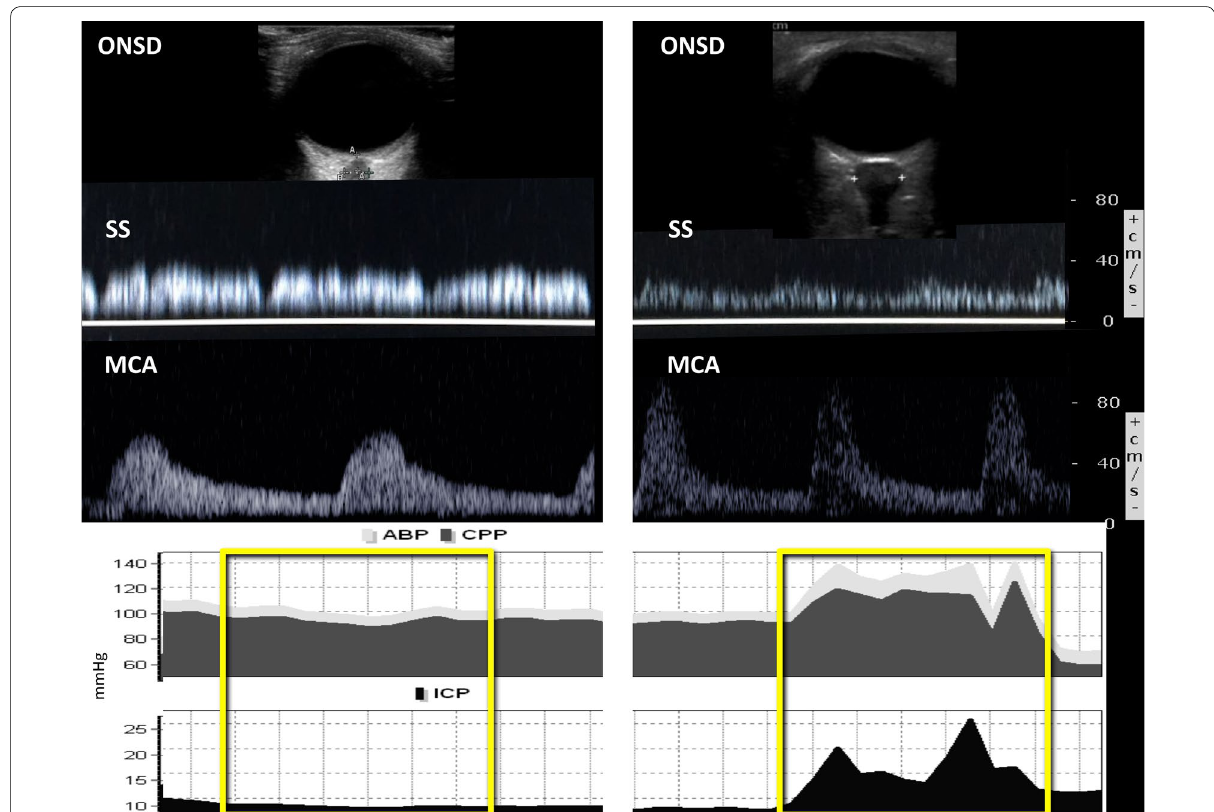
Fig. 2 Invasive and non-invasive intracranial pressure monitoring, respectively, through ICP Bolt and through brain ultrasound (BUS, optic nerve sheath diameter and cerebrovascular Doppler sampling) in a patient with traumatic brain injury and ARDS. A 26-year-old lady was admitted to the intensive care unit after a road traffic accident. She presented with severe traumatic brain injury (TBI) and chest trauma with lung contusions. She was monitored with invasive ICP, intubated and mechanically ventilated. On day 2, she developed hypoxic respiratory failure with bilateral atelectasia. We therefore performed recruitment maneuvers with ABP, CPP, and ICP monitoring and concomitant ONSD and TCD measurements (venous TCD on the SS and arterious TCD on the MCA). Recordings and scanning were performed at baseline (left panels) and during a recruitment maneuver and subsequent increase in PEEP level (right panels). Initially, ICP was below 20 mmHg (mean ONSD 5.2), with PEEP 8, with stable = = arterial blood pressure (ABP) and cerebral perfusion pressure (CPP). After recruitment maneuvers and setting PEEP at 16, ICP spiked up > 20 mmHg, with reflex mean systemic arterial blood pressure (ABP) and cerebral perfusion pressure (CPP) increase. BUS showed consistent increase in middle cerebral artery (MCA) pulsatility index (decrease in diastolic flow, increase in systolic flow), reduction in straight sinus (SS) flow, and increase in optic nerve sheath diameter (ONSD 7 mm). PaCO 2 remained constant during the procedure and the patients experienced no hypotension nor cardiac = output decrease. We therefore reduced PEEP levels and noticed that ICP immediately decreased as well as PI, ONSD and the venous flow on the straight sinus. MCA middle cerebral artery, SS straight sinus, ONSD optic nerve sheath diameter, ABP mean systemic arterial blood pressure,